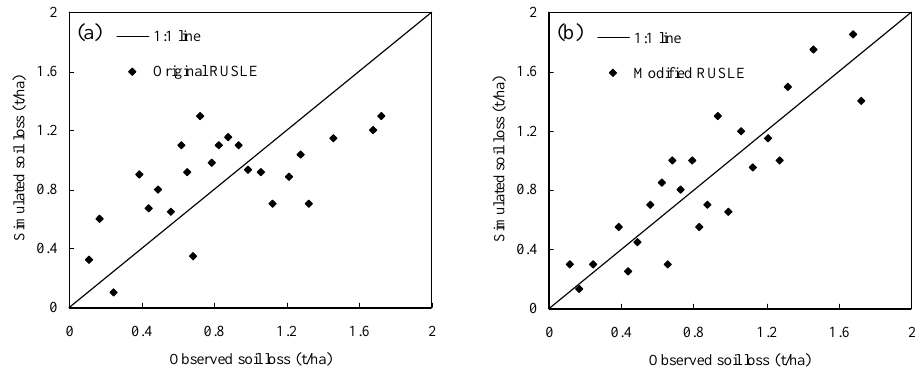
Fig. 8. Comparison between observed and predicted event soil loss during 2009–2011 using (a) original RUSLE and (b) modified RUSLE models for Group 2 runoff plots.